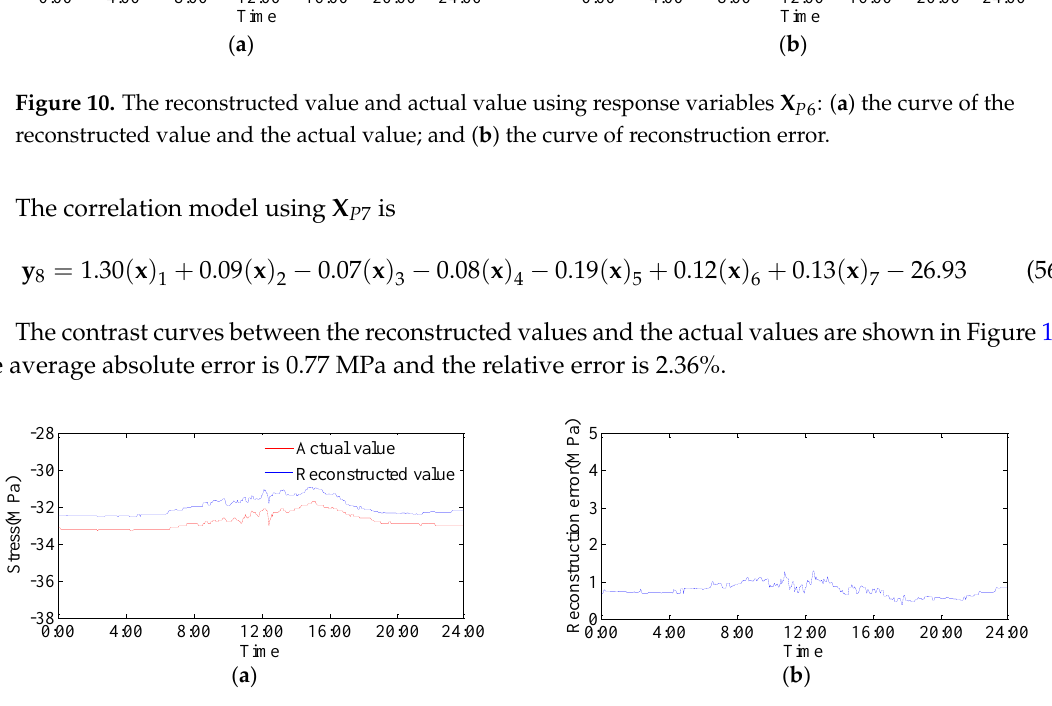
Table 4. The summarized errors using different number of the response variables. Figure 11. The reconstructed value and actual value of the response variables X P 7 : ( a ) the curve of reconstructed value and the actual value; and ( b ) the curve of the reconstruction error.